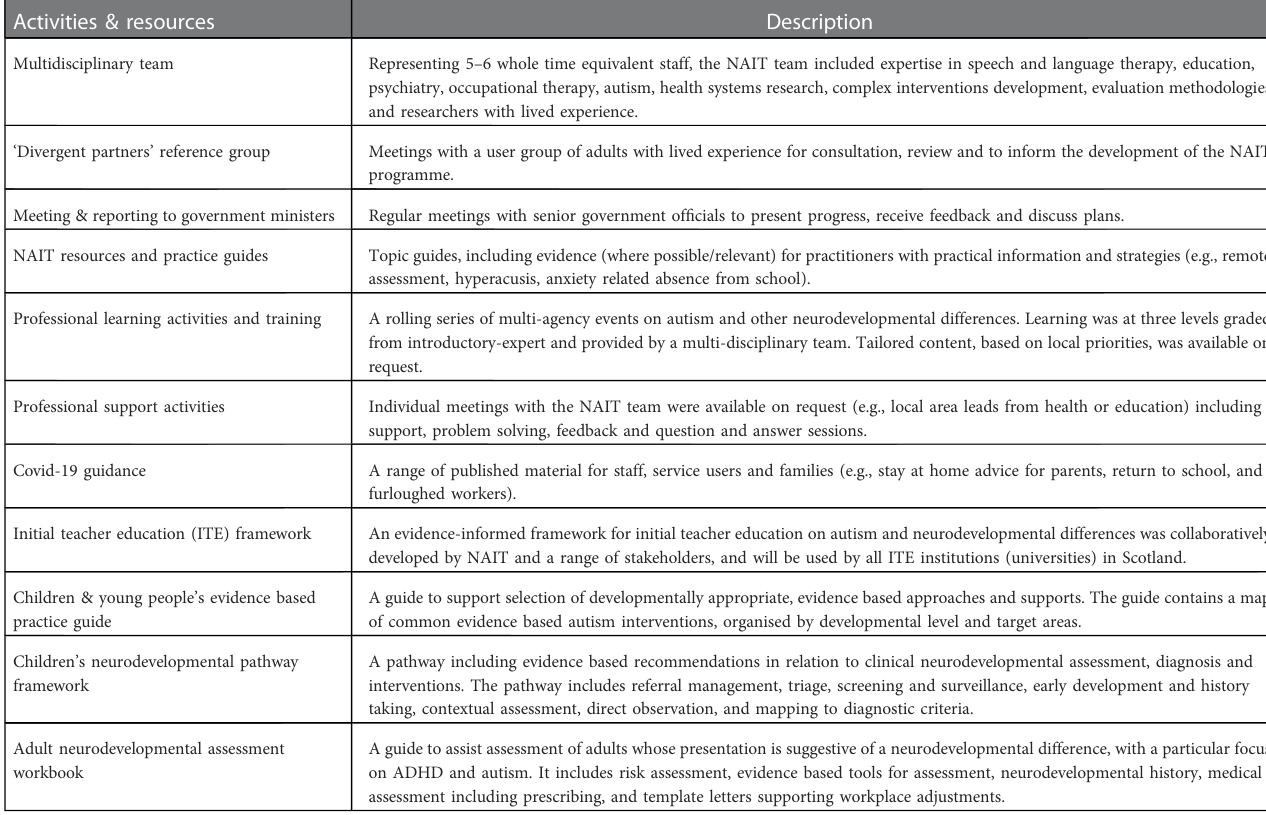
TABLE 3 NAIT activities and resources 2019 –